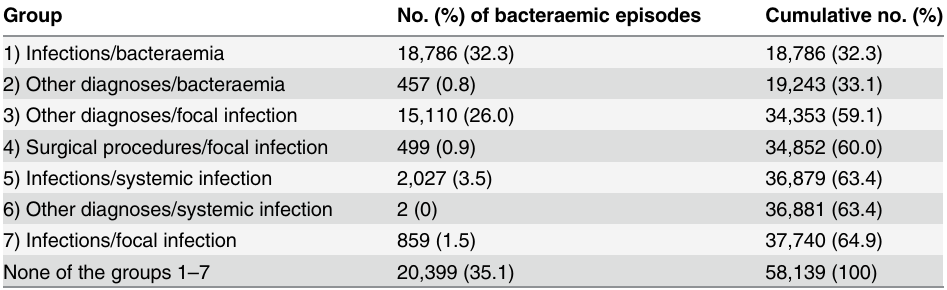
Table 1. Bacteraemic episodes according to groups of diagnosis/surgical procedure codes that indi- cate hospitalization with bacteraemia or a focal infection.